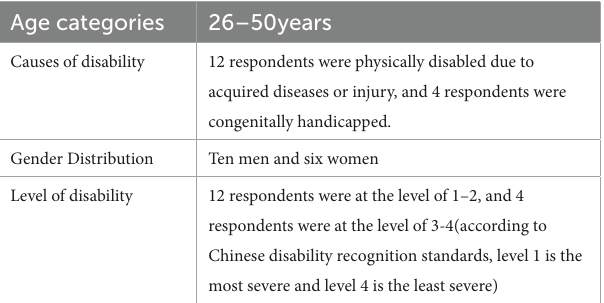
TABLE 1 Sociodemographic profile of 16